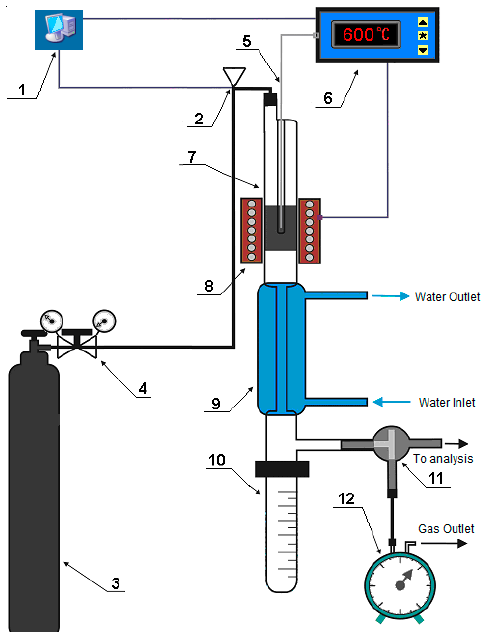
Figure 5. Diagram of catalytic process plant: (1) operator’s workplace; (2) pressure regulator; (3) cylinder with PBF ; (4) pressure reducer; (5) thermocouple; (6) temperature regulator; (7) reactor; (8) heating element; (9) water cooler; (10) liquid products collector; (11) dispenser valve; (12) gas meter.